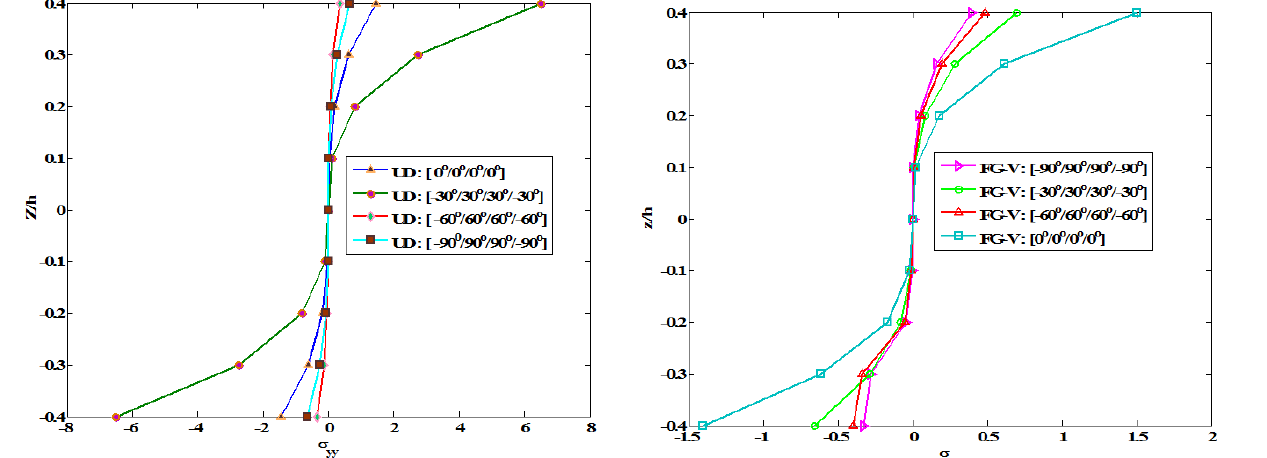
plate with four edges simply supported subjected to uni- form transverse load q 0 with volume fraction V CNT =